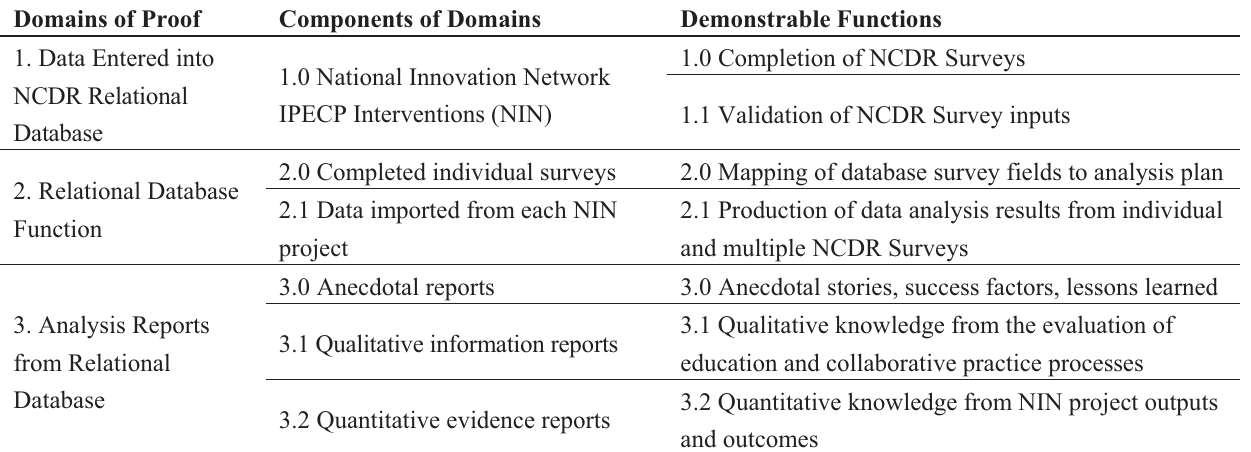
Table 1. Nexus innovation network-national center data repository proof of concept